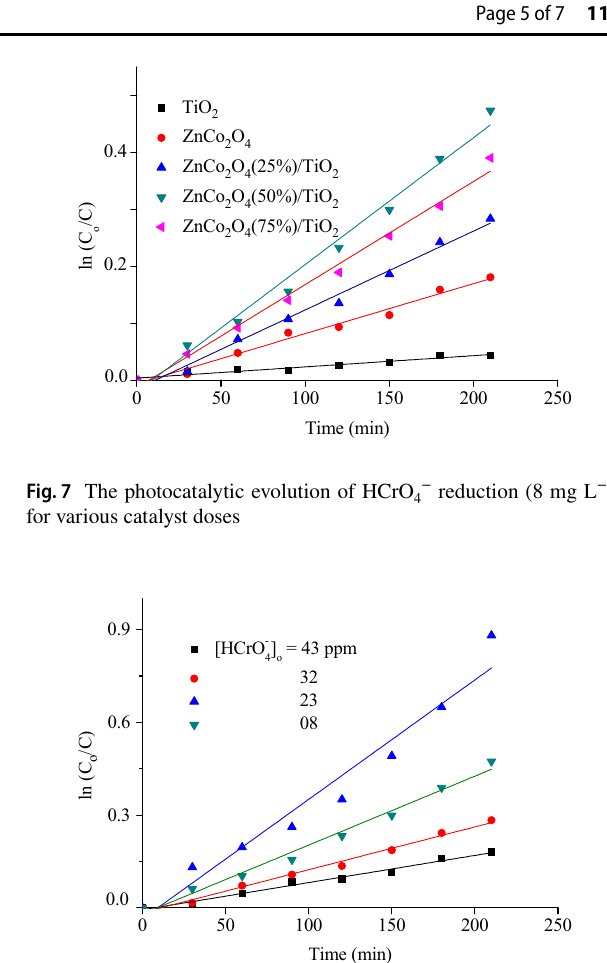
2 O 4 /TiO 2 hetero-system